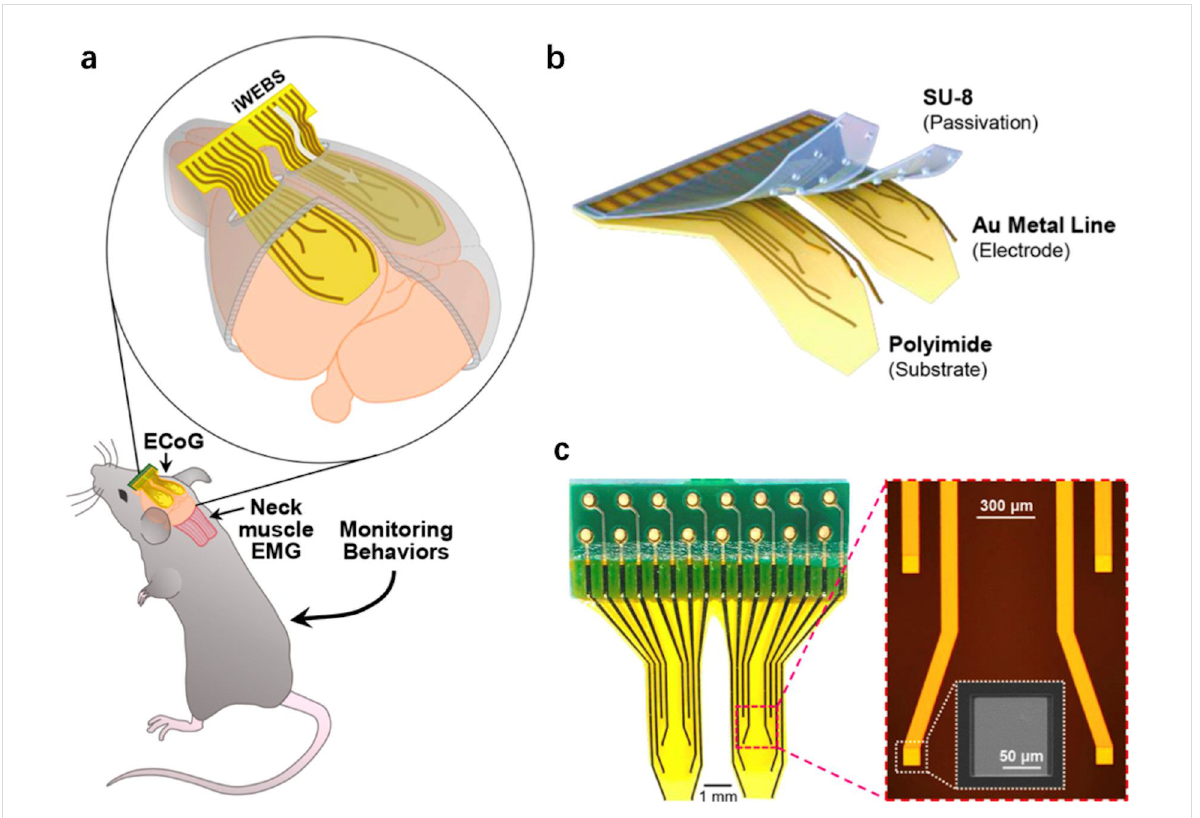
Figure 5: Features of the iWEBS array. (a) Implantation in free-moving mice. (b) Layer components. (c) Structure of recording units. Figure 5 was adapted with permission from [76], Copyright 2016 American Chemical